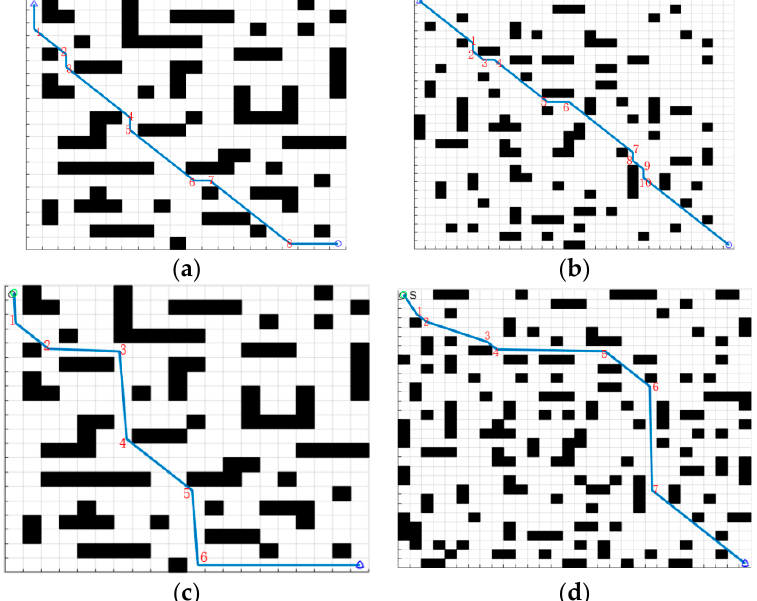
Figure 7. Traditional A* algorithm and improved A* algorithm. ( a ) Case 1, ( b ) Case 2, ( c ) Case 1 ( d ) Case 2. ( The red number in the figure represents the number of nodes in the path, the blue solid line is the planned route, the black grid is the obstacle, and the white grid is the driving area).